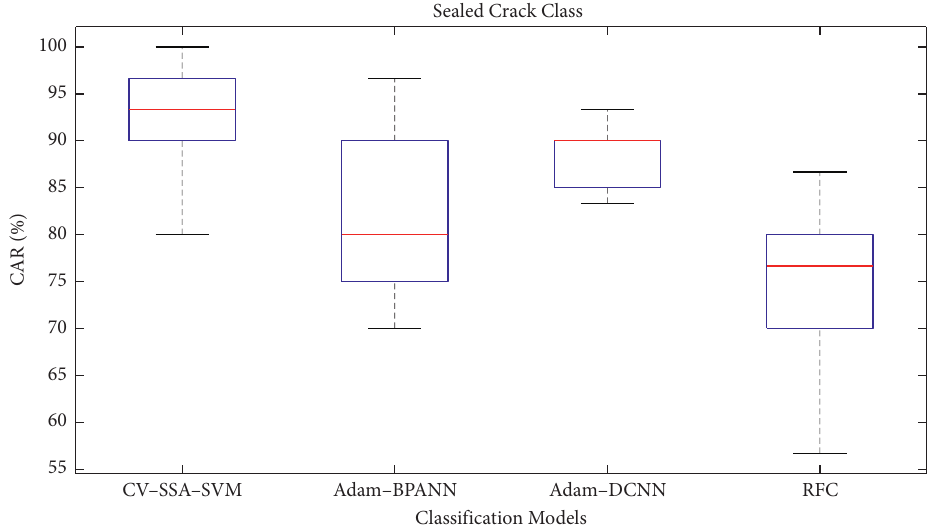
Figure 14: Box plot of classification accuracy for the “sealed crack” class.